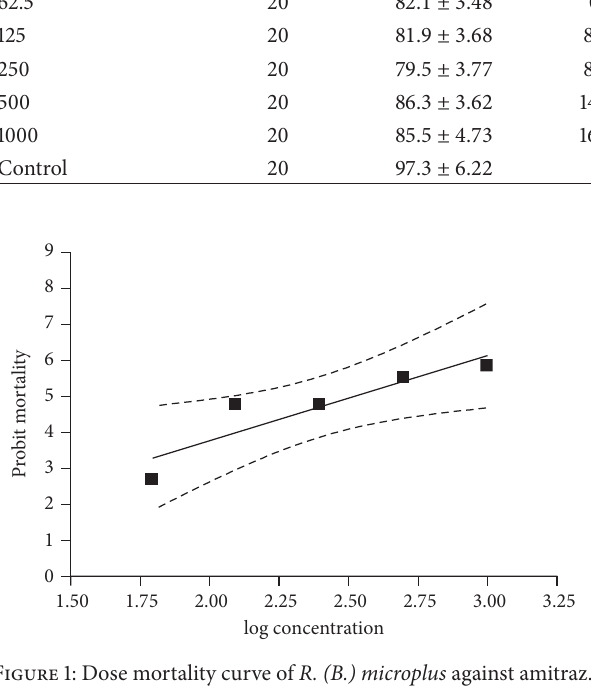
Table 1: Dose-dependent response of amitraz against R. (B.) microplus collected from SBS Nagar, Punjab. Concentration (ppm) Number of ticks